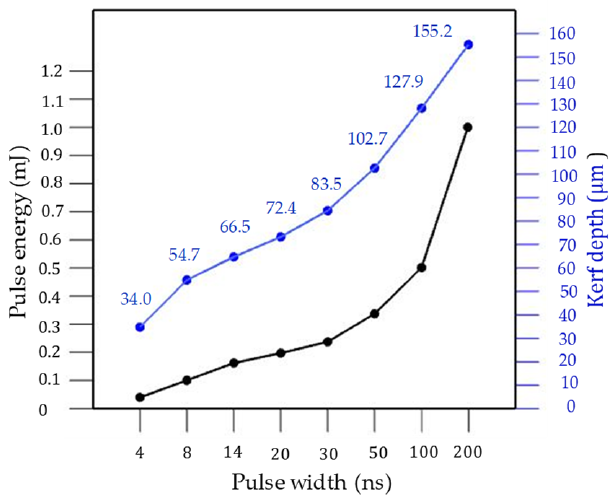
Figure 11. Correlation between variation in pulse width, pulse energy, and kerf depth. Both pulse energy and kerf depth increase with an increase in pulse width.